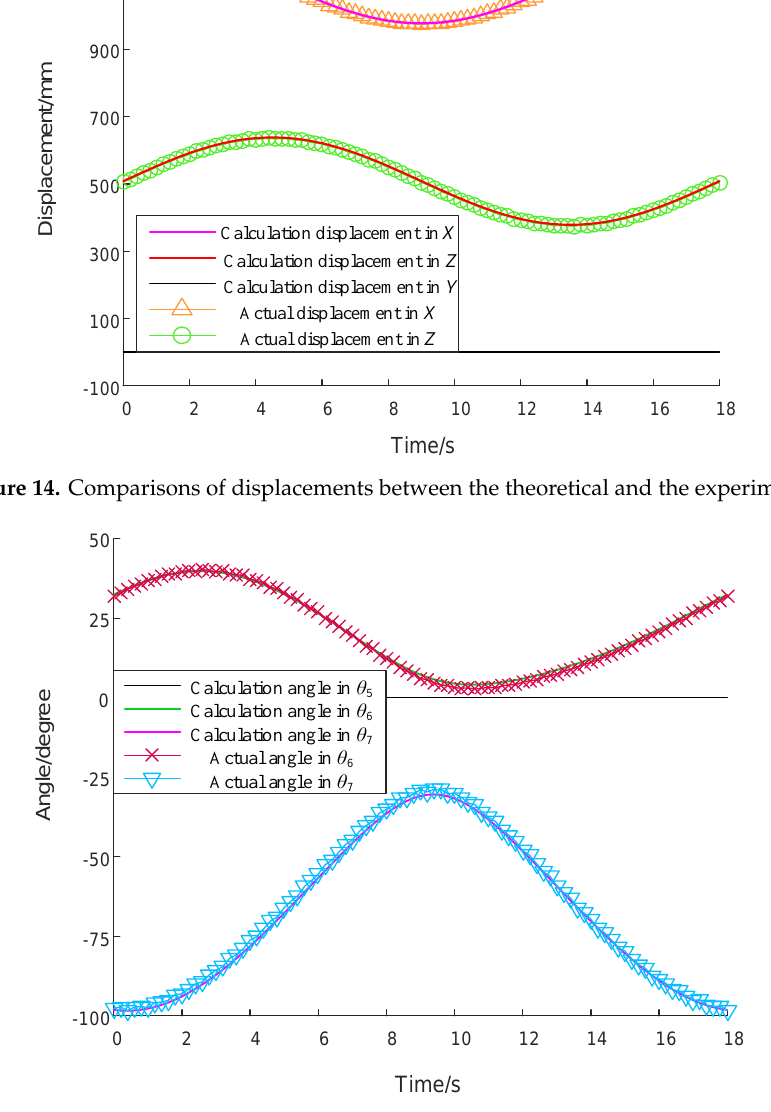
Figure 15. Comparisons of angles between the theoretical and the